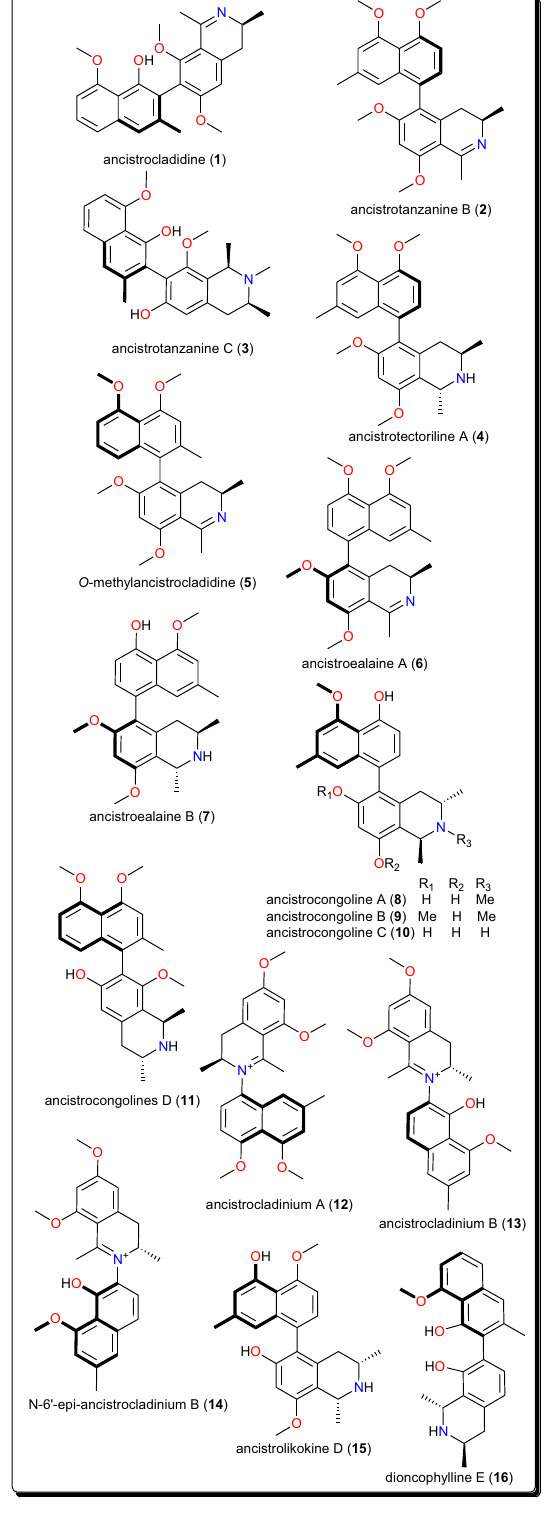
Fig. 2 Antiprotozoal naphthylisoquinoline alkaloids